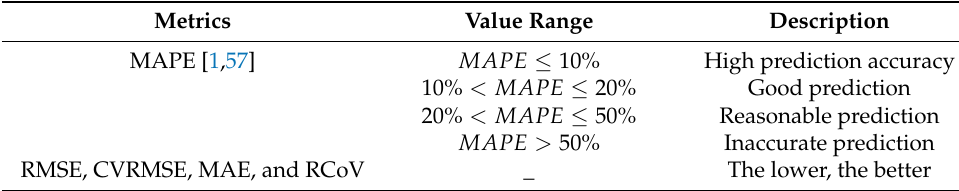
Figure 4. Architectural design of the proposed models. Table 2. Performance evaluation acceptability criteria.